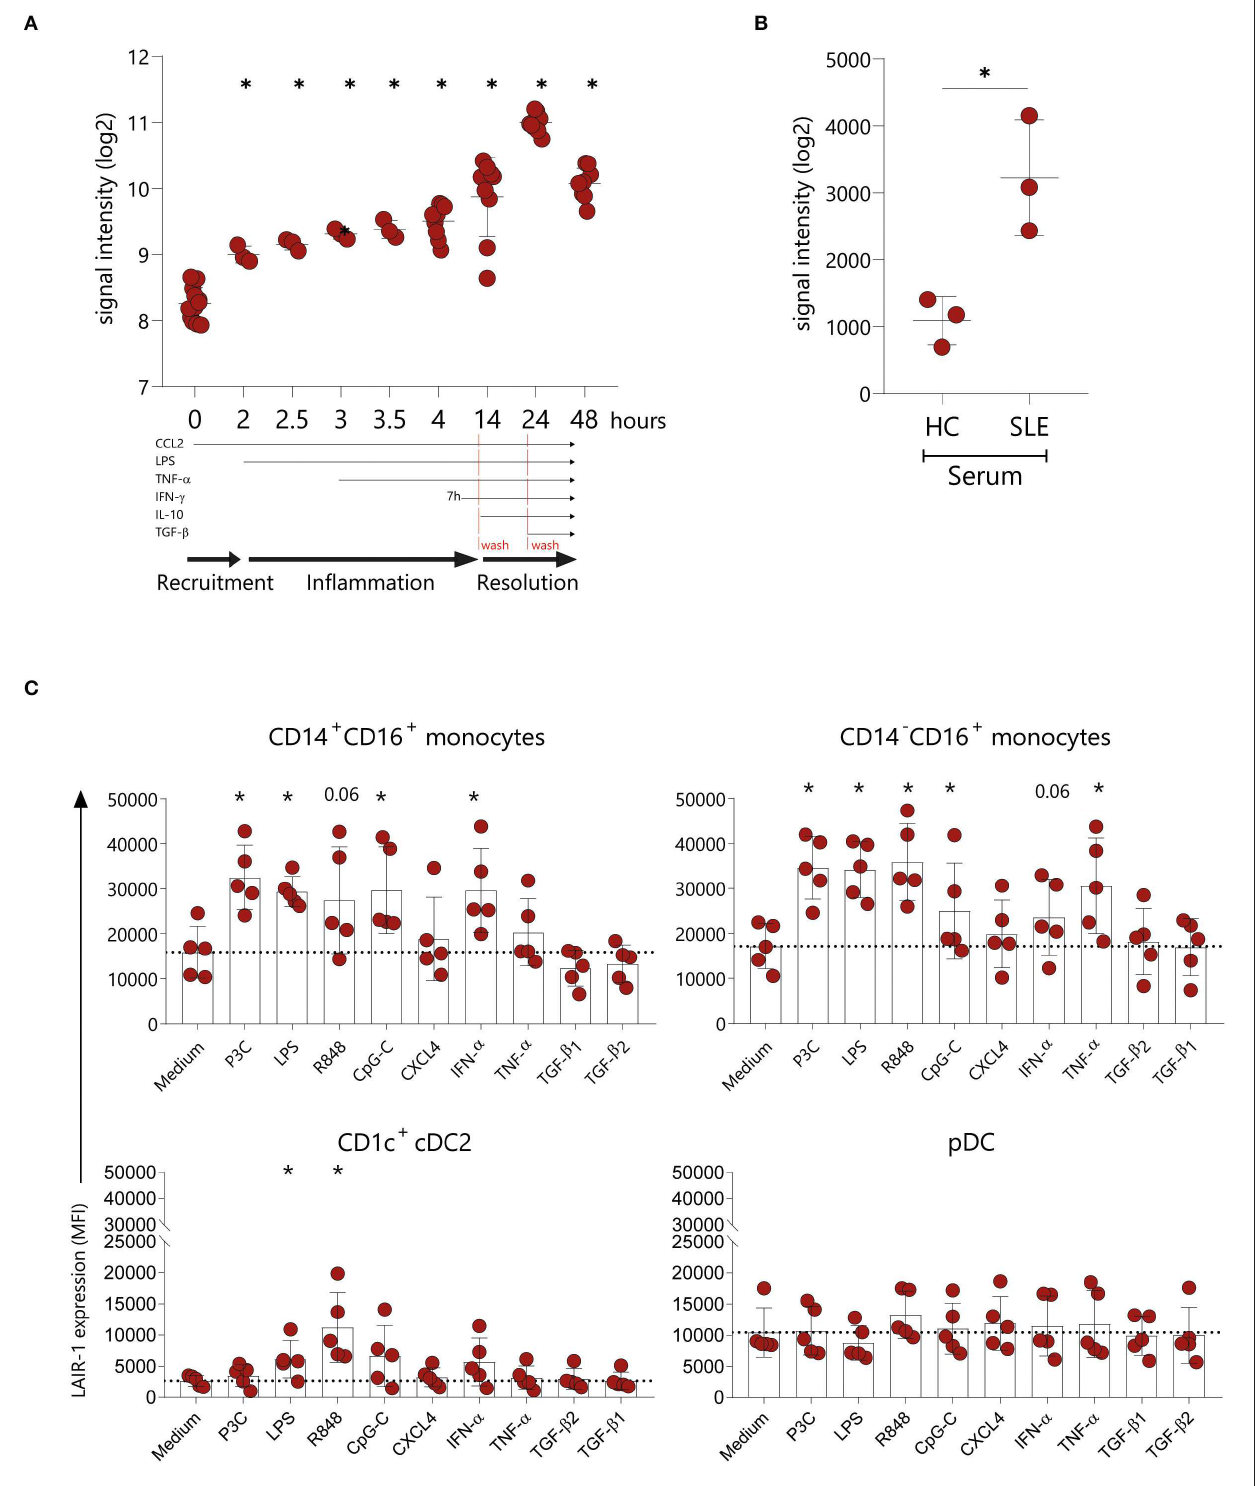
FIGURE 2 | LAIR-1 is upregulated upon inflammatory triggers. LAIR-1 gene expression was determined by array profiling and retrieved from publicly available datasets. (A) Kinetics of the LAIR1 expression in human monocytes from an in vitro model of inflammation (GSE47122). Results are represented as mean with SD. Differences were considered statistically significant when * p < 0.05 vs. time-point 0 condition (one-way ANOVA test). (B) LAIR1 expression in healthy blood monocytes exposed during 6h to 20% serum from healthy controls (HC) or newly diagnosed, untreated systemic lupus erythematosus (SLE) patients